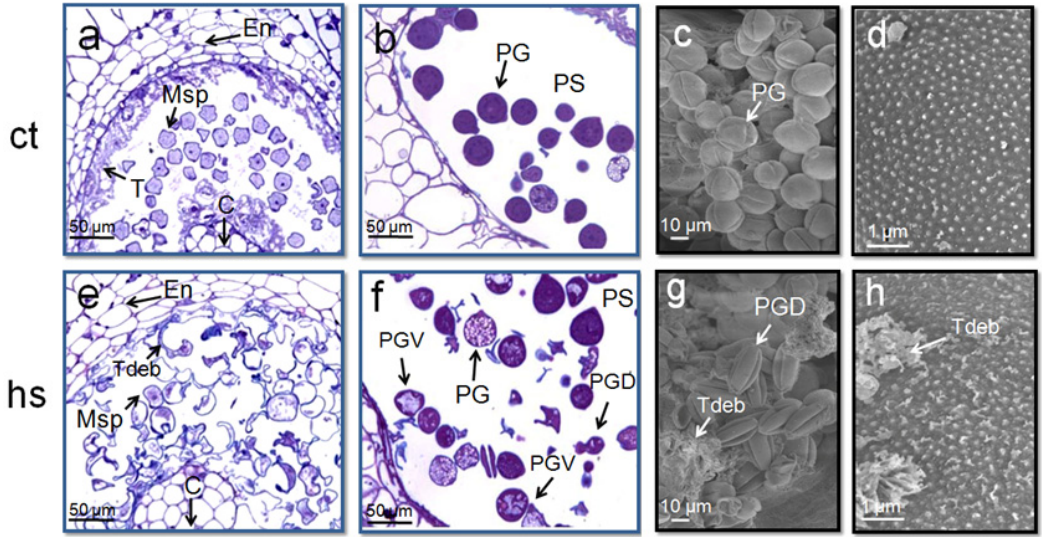
Figure 3. Cytological alterations in tomato anthers and pollen grains after 3 days of mild hs of 36 °C. Panels ( A , B , E , F ) show sections of anthers from young flower buds ( A , E ) and pollen grains from flowers at anthesis stage ( B , F ) harvested from tomato plants (cv Saladette). ( A ) Anthers from plants grown under control conditions (ct: 26 °C/19 °C; day/night) with normally developed endothecium, tapetum and microspores. ( E ) Similar anthers from plants grown at high temperature (hs: 36°C/26°C; day/night) in which tapetum and most of microspores are degenerated. ( B ) Normally developed pollen grains with densely stained cytoplasm in pollen sac. ( F ) Pollen sac of anthers treated with hs in which pollen grains are degenerated or show abnormal vacuolization. (C,D,G,H) Scanning electron micrographs of mature pollen grains. ( C , D ) Well hydrated pollen grains and the exine with tiny spinules, respectively, from plants grown at normal temperatures. ( G , H ) Not hydrated pollen grains and tapetum debris ( G ) and an irregular exine surface with tapetum debris (H) from pollen grains in anthers treated with